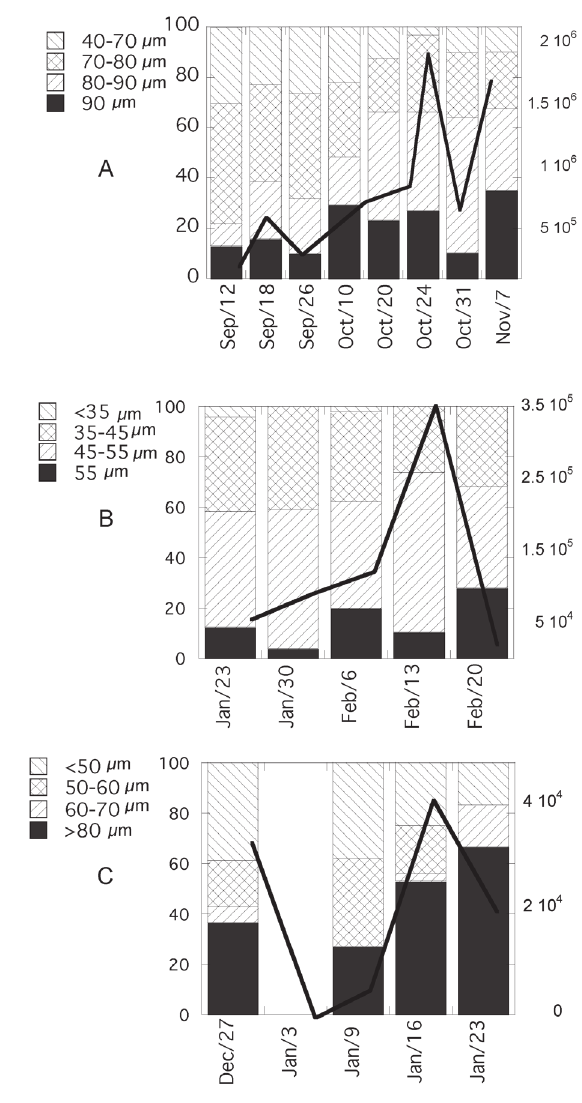
Fig . 7. – cell abundance (cell l -1 ) and percentage of size distribu- tion during the blooms of Pseudo-nitzschia spp in alfacs Bay. a) P. calliantha (n=394), B) P. delicatissima ( n =202), and c) P. fraudu- lenta ( n =124)